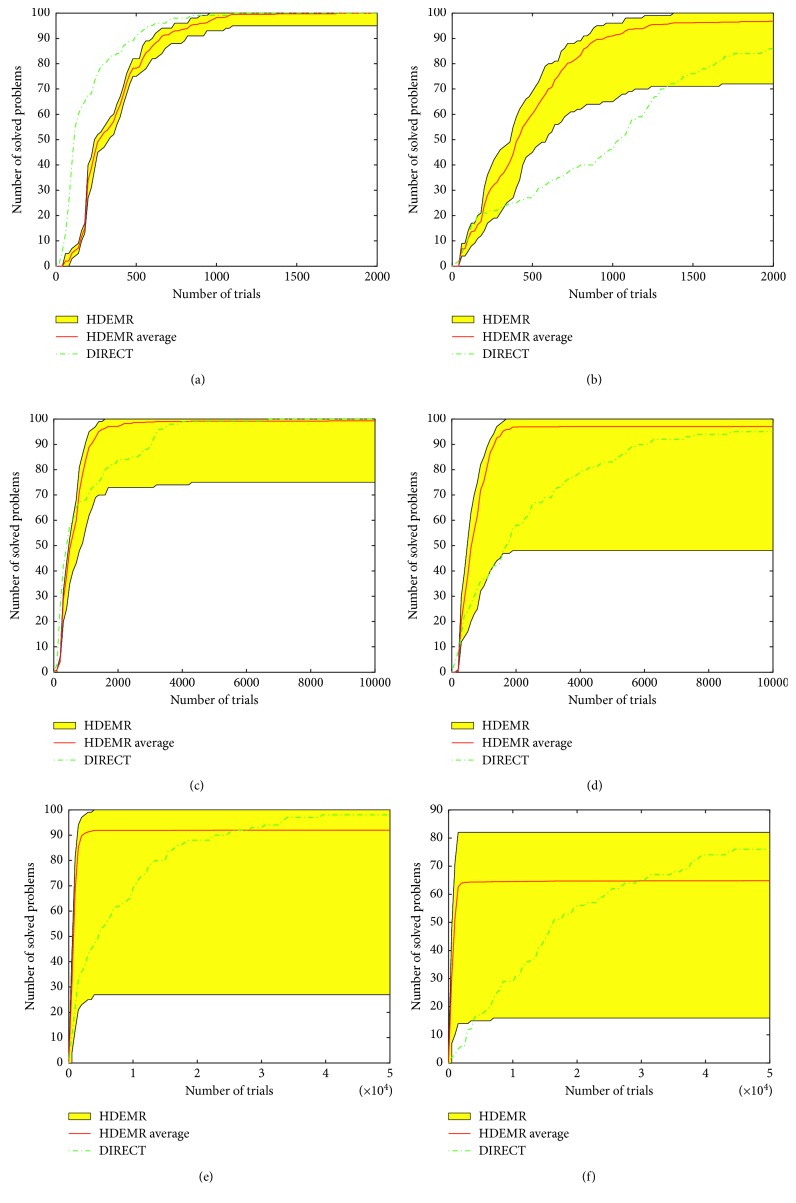
Operational characteristics built on 2-, 3-, 4-dimensional classes of GKLS test functions for DIRECT and operational zones for HDEMR. (a) Operational characteristics for DIRECT and the operational zone for HDEMR for the simple 2-dimensional class. (b) The same as (a) for the hard class. (c) Operational characteristics for DIRECT and the operational zone for HDEMR for the simple 3-dimensional class. (d) The same as (c) for the hard class. (e) Operational characteristics for DIRECT and the operational zone for HDEMR for the simple 4-dimensional class. (f) The same as (e) for the hard class.